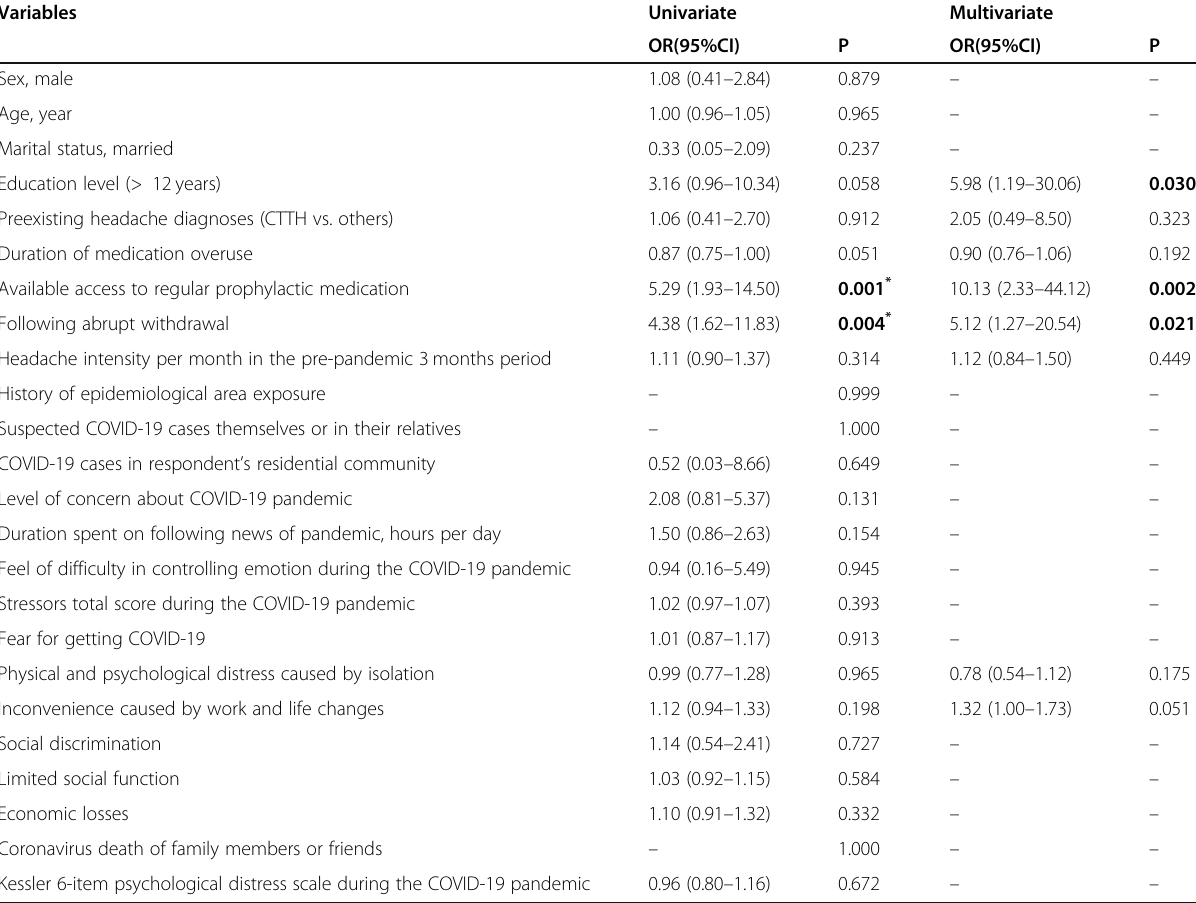
Table 4 Univariate and multivariate logistic analysis to identify independent variables decreasing headache intensity per